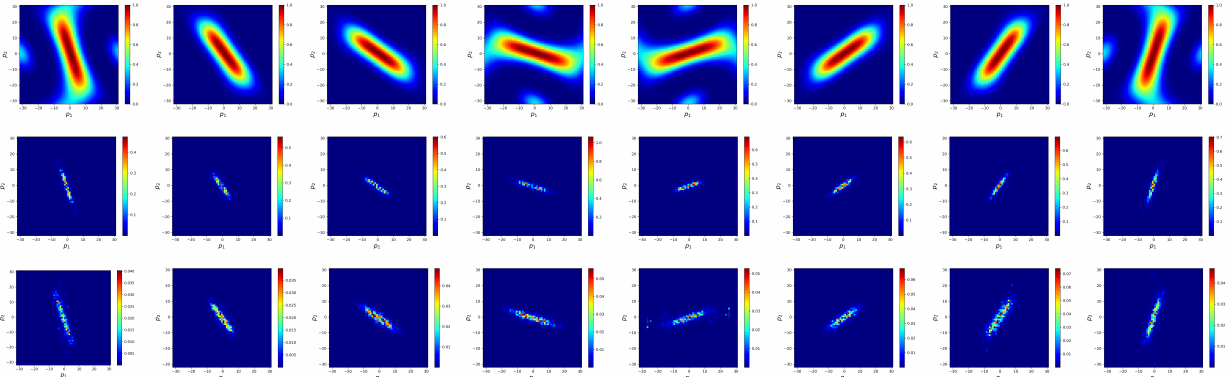
Figure 5. Case 2 of Equation (13) for different anisotropic direction θ . The first row represents the convergence factor of Φ . The second row represents the error distribution in the frequency space before correction. The third row represents the learned error by H